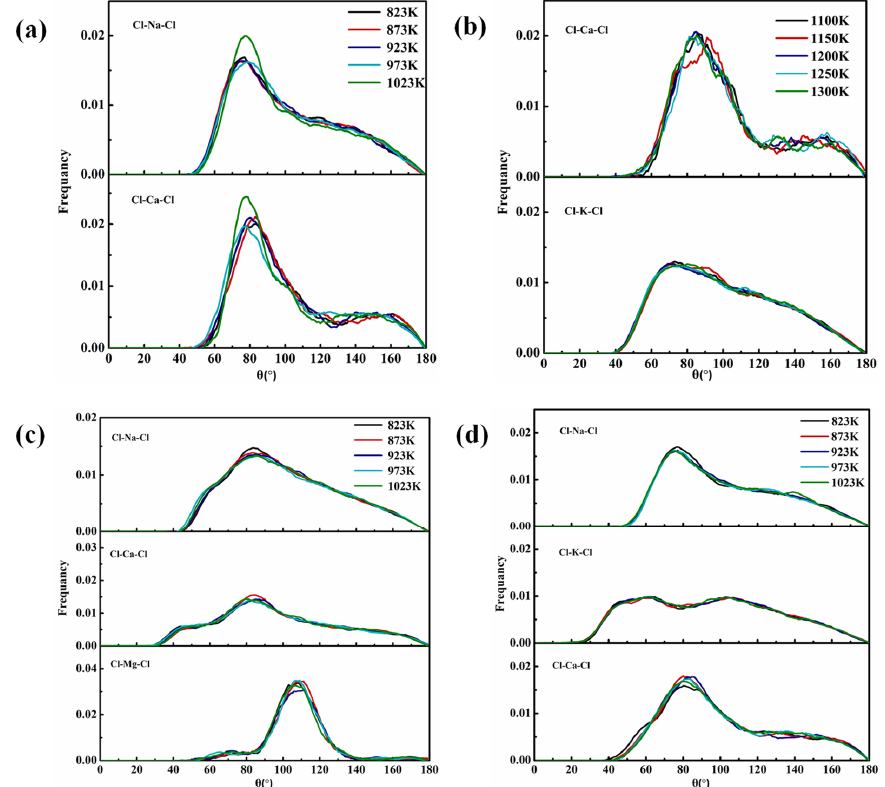
Figure 8. Bond angle distribution of different chloride eutectic molten salts ( a ) NaCl ‐ CaCl 2 , ( b ) KCl ‐ CaCl 2 , ( c ) NaCl ‐ CaCl 2 ‐ MgCl 2 and ( d ) NaCl ‐ CaCl 2 ‐ KCl.